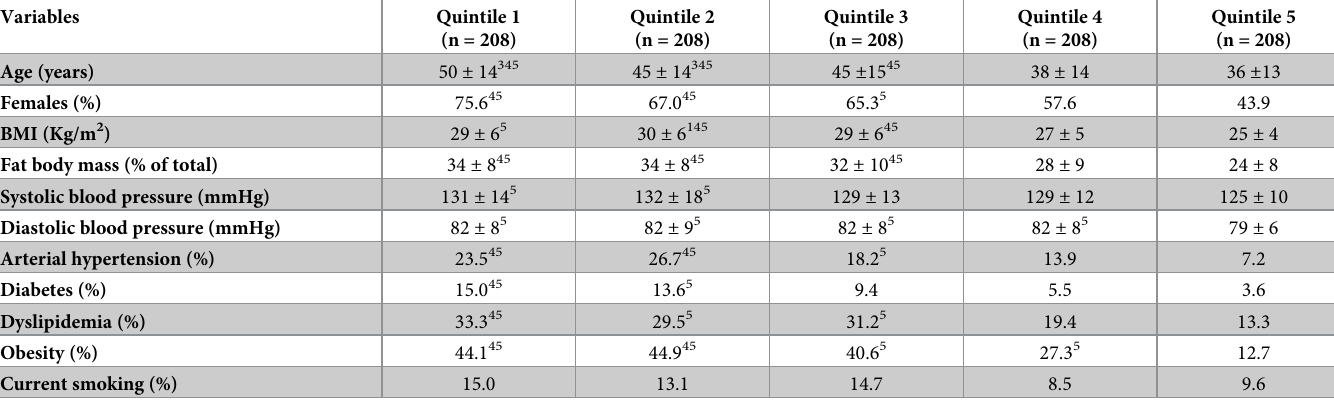
Table 1. General characteristics of the studied sample according to the quintiles of very vigorous physical activity (n = 1040).